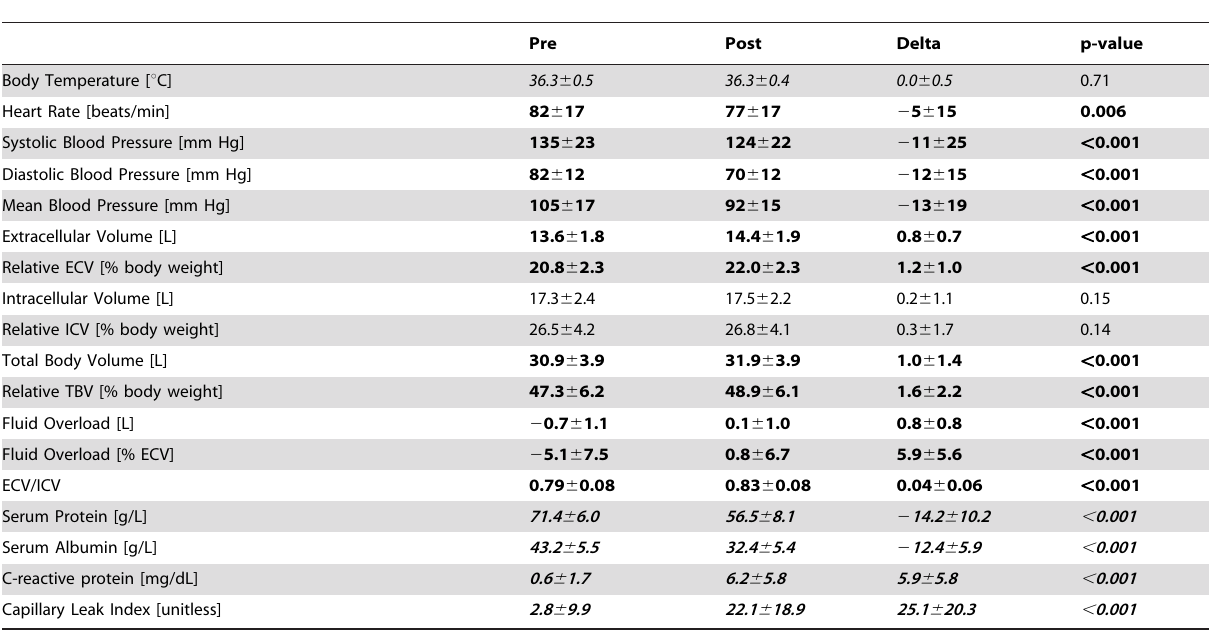
Table 2. Vital signs, volume status and body composition before and after